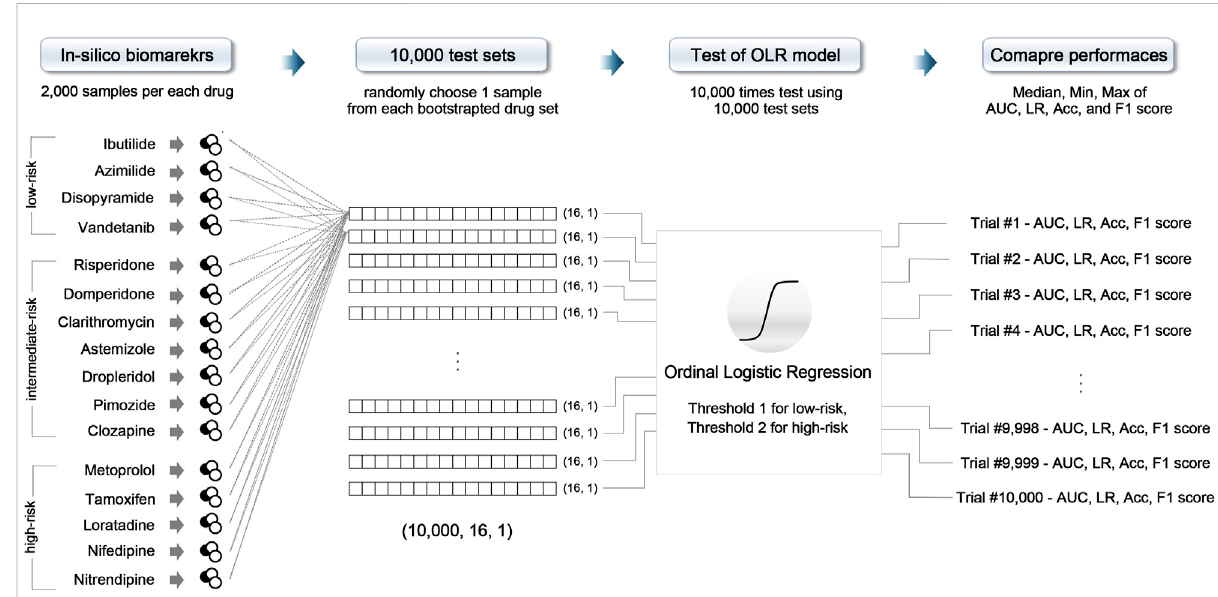
FIGURE 1 Schematic of the 10,000-repeated testing method; OLR, ordinal logistic regression; AUC, area under the receiver operating curve; LR, likelihood ratio; Acc,